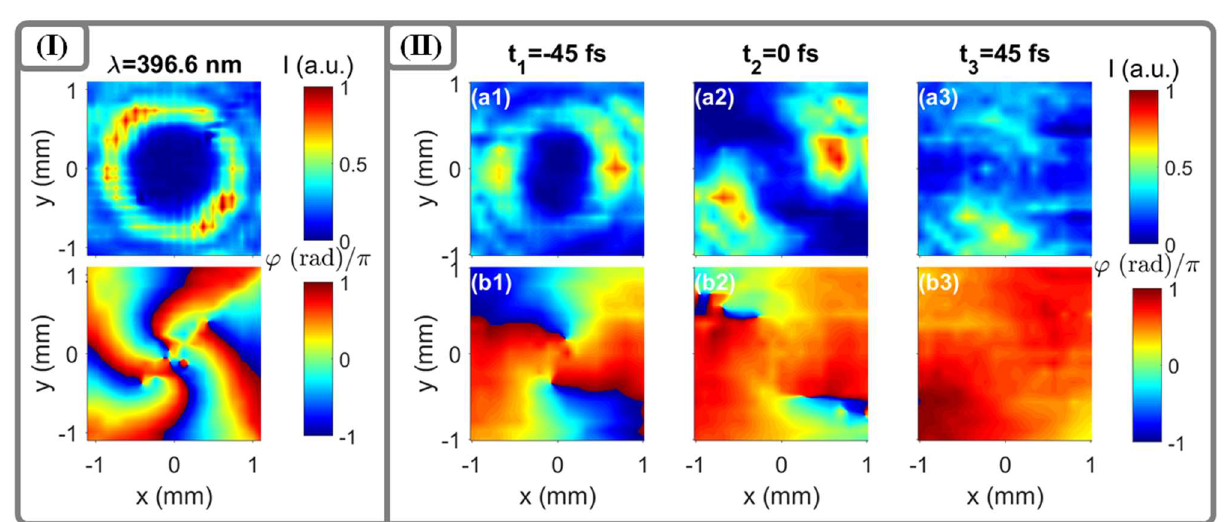
Fig. 2. Intensity (first row) and phase (second row) profiles for: (I) Frame for the central wavelength (396.6 nm) of the complete spatiospectral characterization of an ℓ=+4 optical vortex in the visible range. (II) Three temporal frames of the complete spatiotemporal characterization of the combination of ℓ=+2 and ℓ=0 optical vortices with a 65-fs delay between